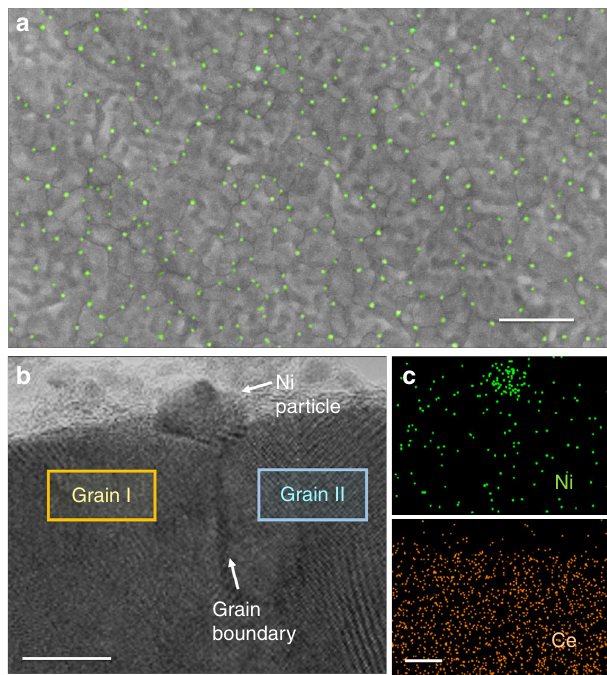
Fig. 2 Microscopic images of metal nanoparticles on Sm-doped CeO 2 thin fi lm. a Top-view fi eld emission scanning electron microscopy (FE-SEM) image of synthesized Ni nanoparticles on Sm-doped CeO 2 (SDC) surfaces after annealing at 700 °C in reducing condition. For clarity, the nanoparticles were intentionally colored using Adobe Photoshop. b Cross- sectional scanning transmission electron microscope (STEM) image